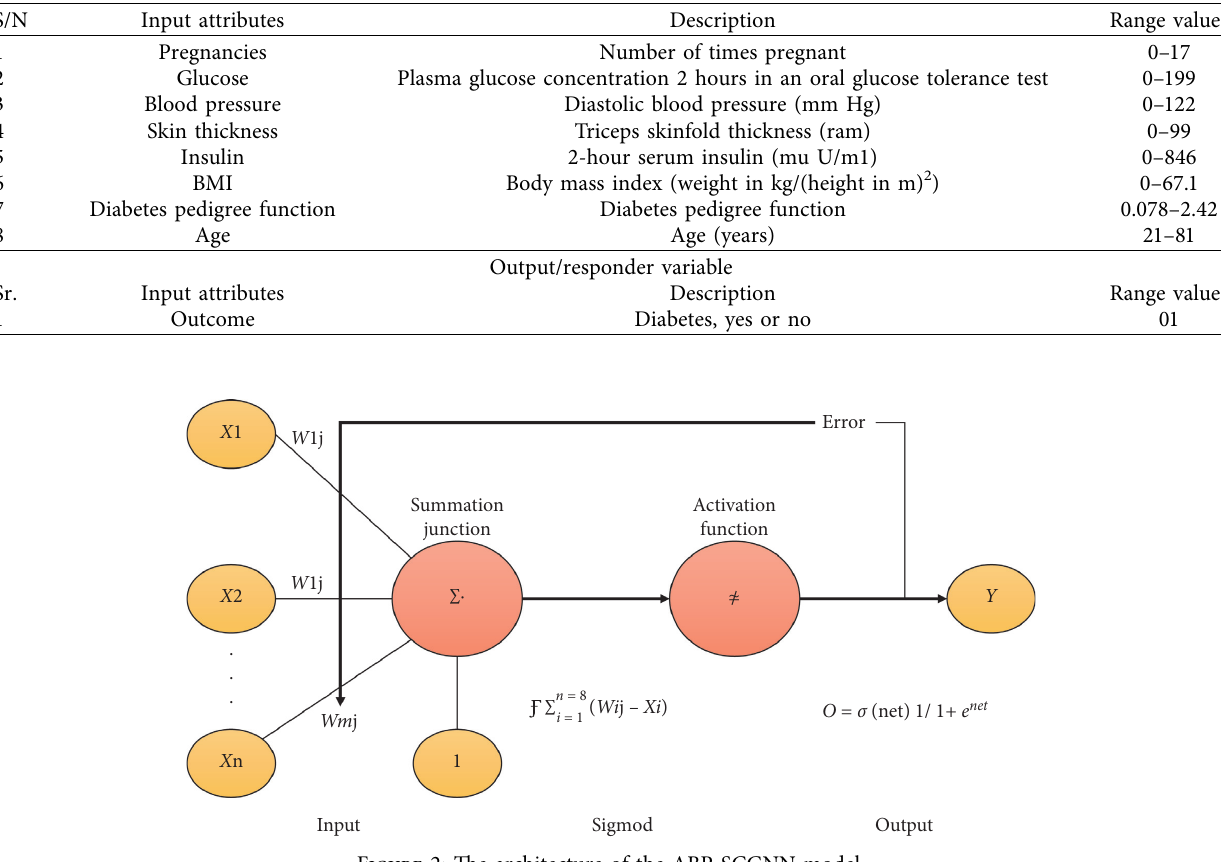
Figure 2: The architecture of the ABP-SCGNN model.